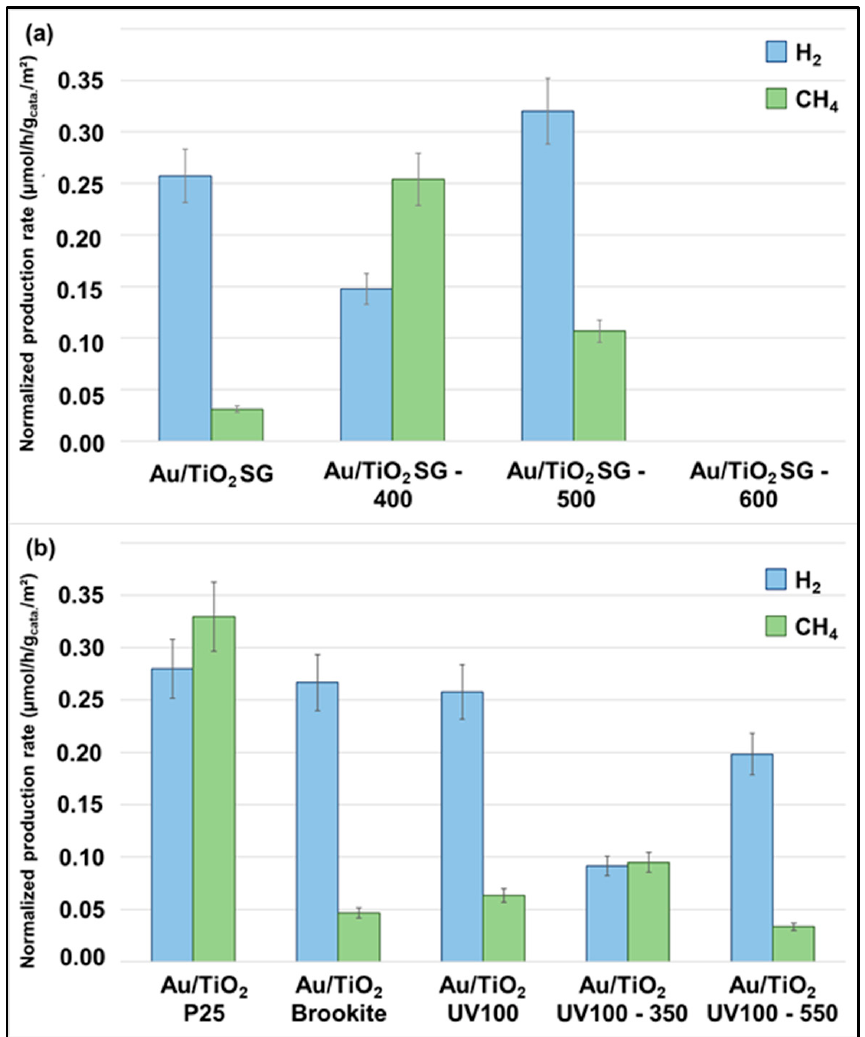
Figure 6. Specific normalized H 2 and CH 4 production rates (CO 2 /H 2 O = 96/4 mol. ratio) at 0.3 mL/min continuous flow under solar light irradiation of ( a ) Au/TiO 2 SG – X and ( b ) Au/TiO 2 P25, Au/TiO 2 Brookite and Au/TiO 2 UV100 – X commercial-based samples.